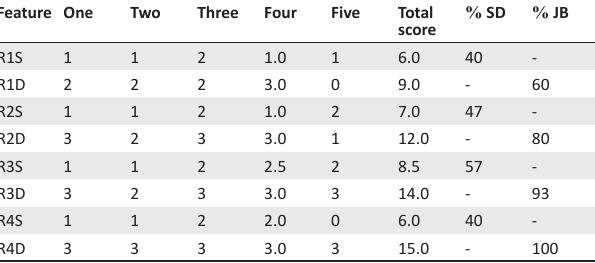
TABLE 4: Morphological index scores for sub-dermal and juxta-bone biopsies from injured